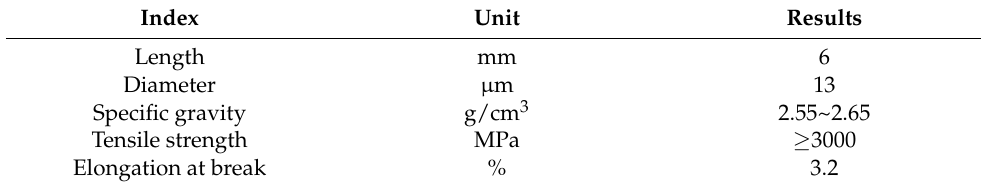
Table 5. Basic performances of basalt fiber.